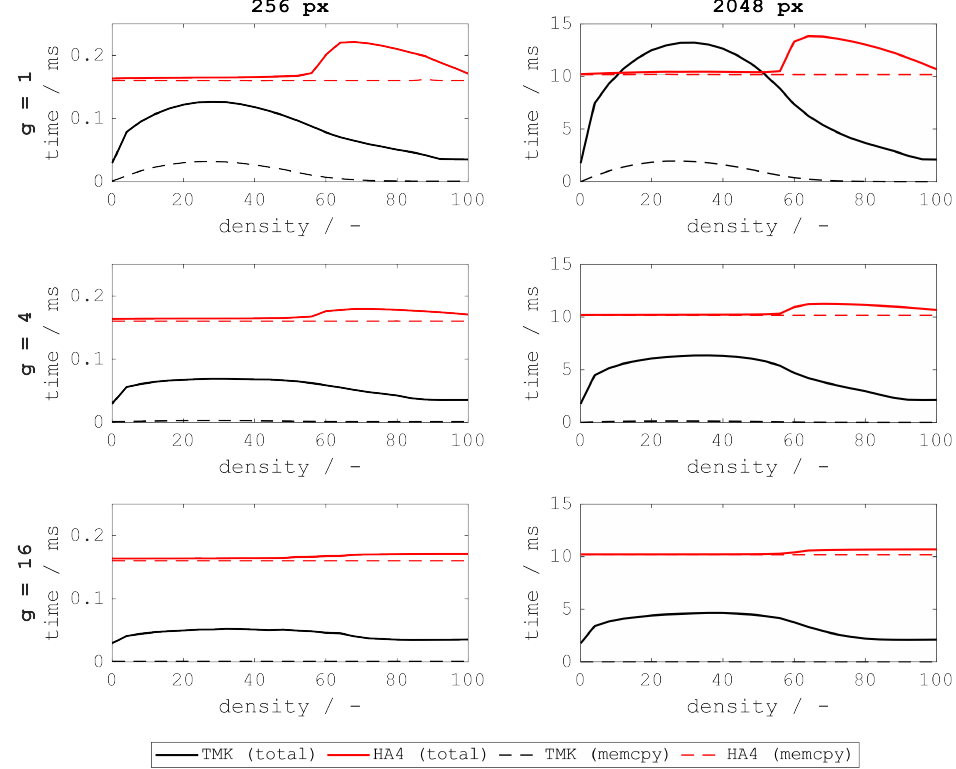
Figure 4. Comparison of execution time (System A) vs. density for different granularities g for images with 256 × 256 pixels and 2048 × 2048 pixels. Solid lines inidicate total execution time (including cudaMemcpy ). Dashed lines show the respective cudaMemcpy time for the feature array (device to host). Errobars are omitted for clarity (standard deviation < 3% in all